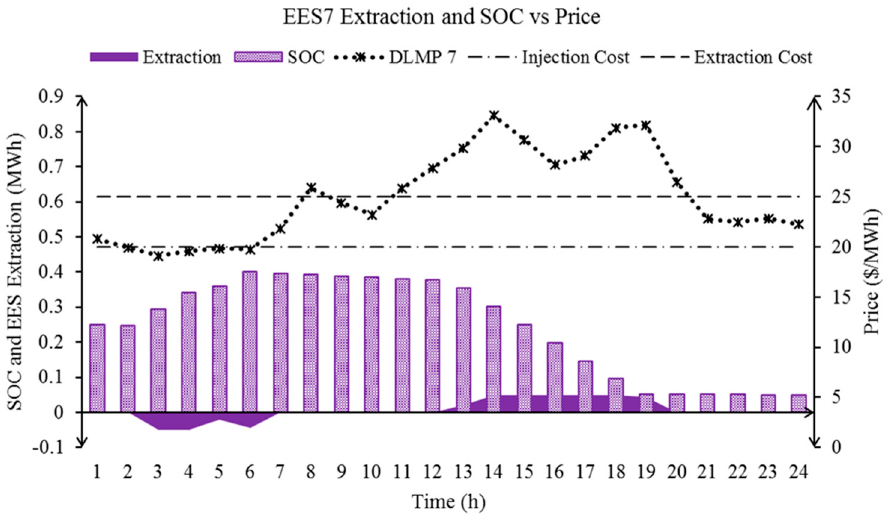
Figure 12. EES7’s schedule is dependent upon the DLMP at Bus 7.